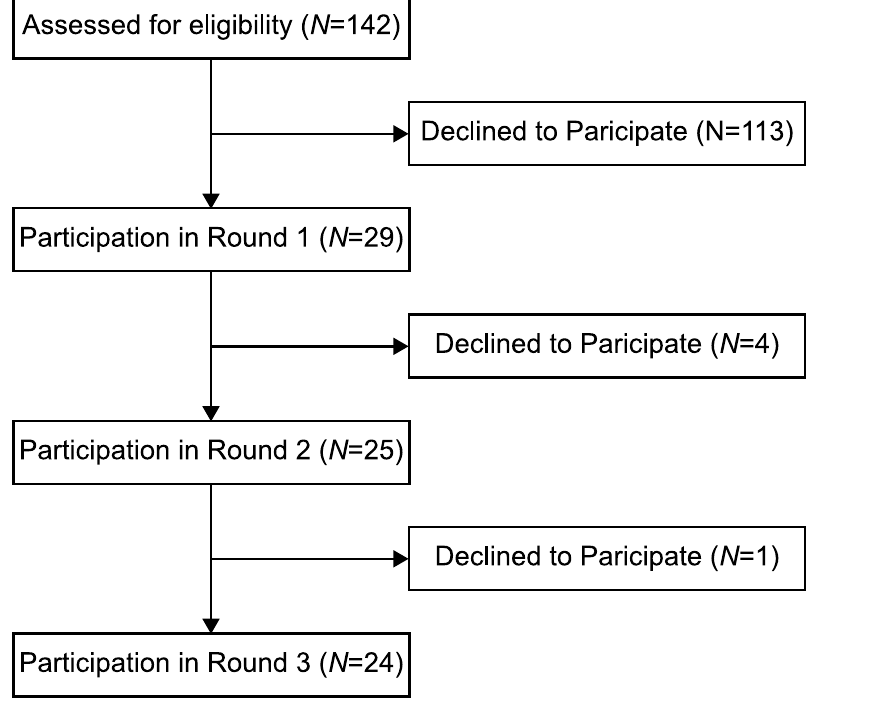
Fig 2. Participation in each round of this Delphi